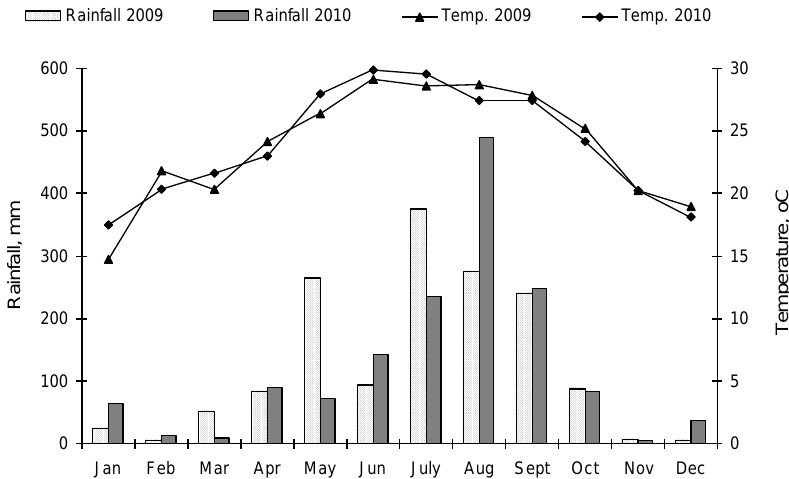
Figure 1. Average environmental temperature and rainfall in Bavi in 2009 and